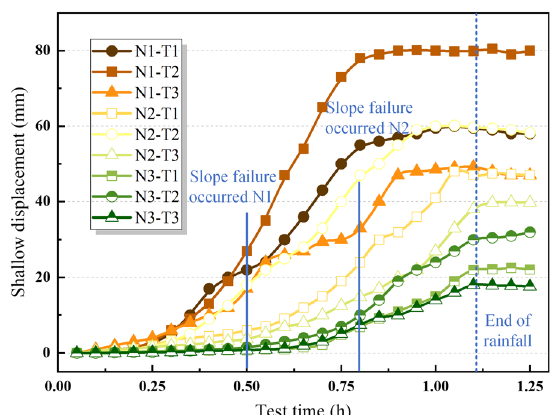
Fig. 10 Time history chart of surface displacement change under different rainfall